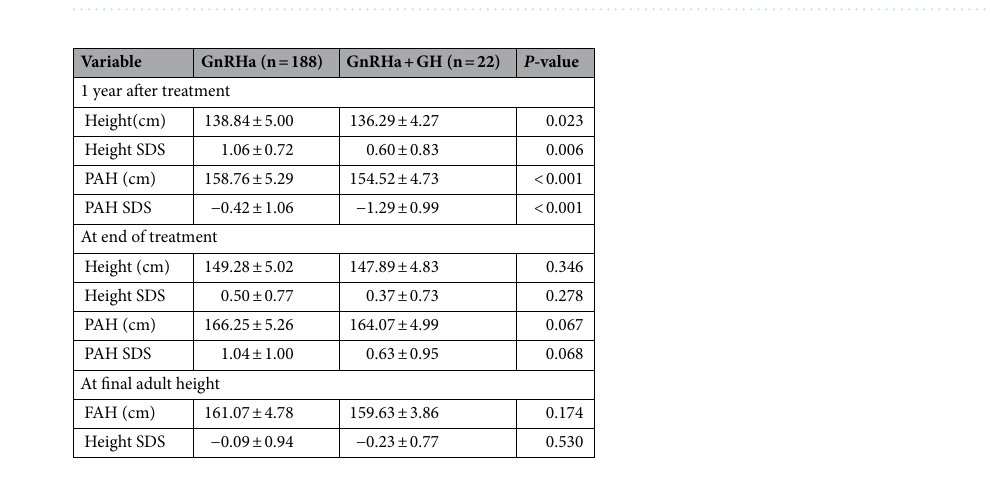
Table 2. Changes in auxological parameter after GnRHa treatment or GnRHa + GH combination treatment. GnRHa Gonadotropin-releasing hormone agonist, GH Growth hormone, CA Chronological age, BA Bone age, SDS Standard deviation score, BMI Body mass index, PAH Predicted adult height-calculated with advanced table of baley–Pinneau (BP) method, FAH Final adult height.